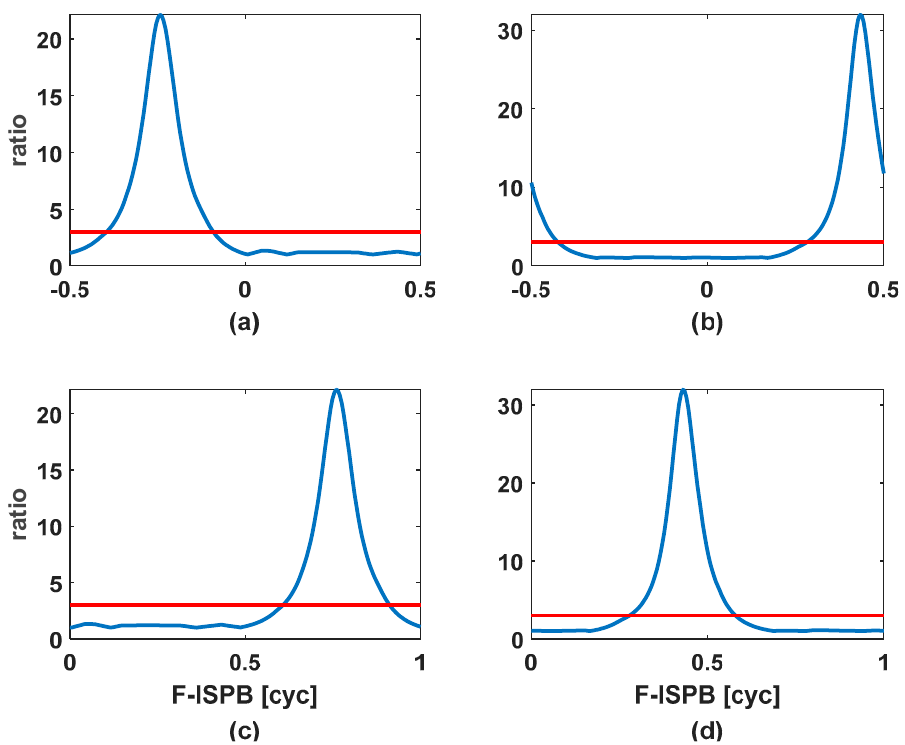
Figure 1. Relationship between ratio and F-ISPB for first epoch. ( a , c ) The baseline CUTB–CUTC. ( b , d ) The baseline CUTB–CUT0.